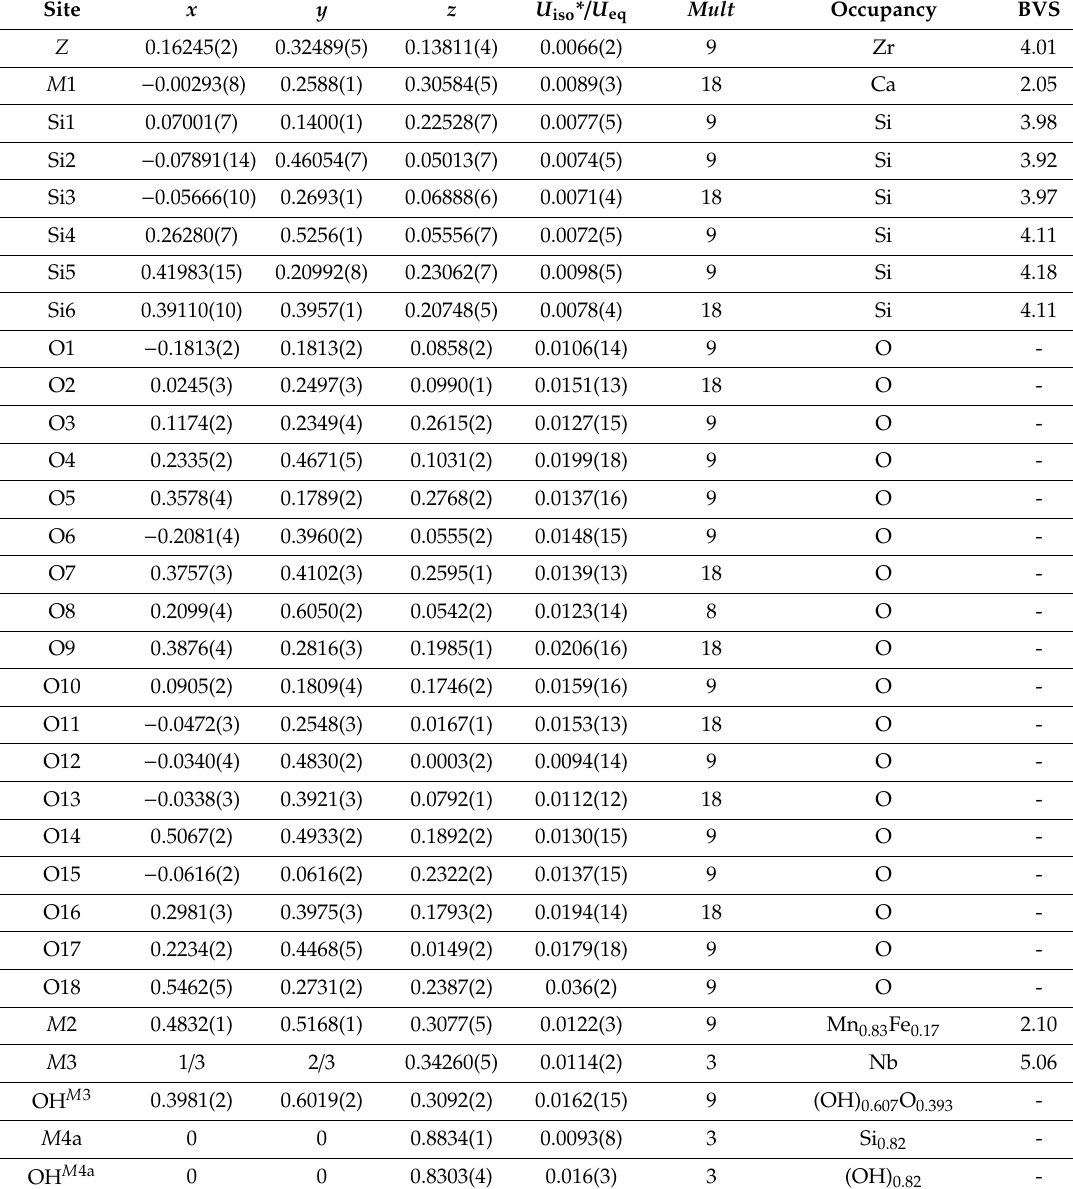
Table 4. Atom coordinates ( x , y , z ), atomic displacement parameters ( U , Å 2 ), site multiplicities ( Mult